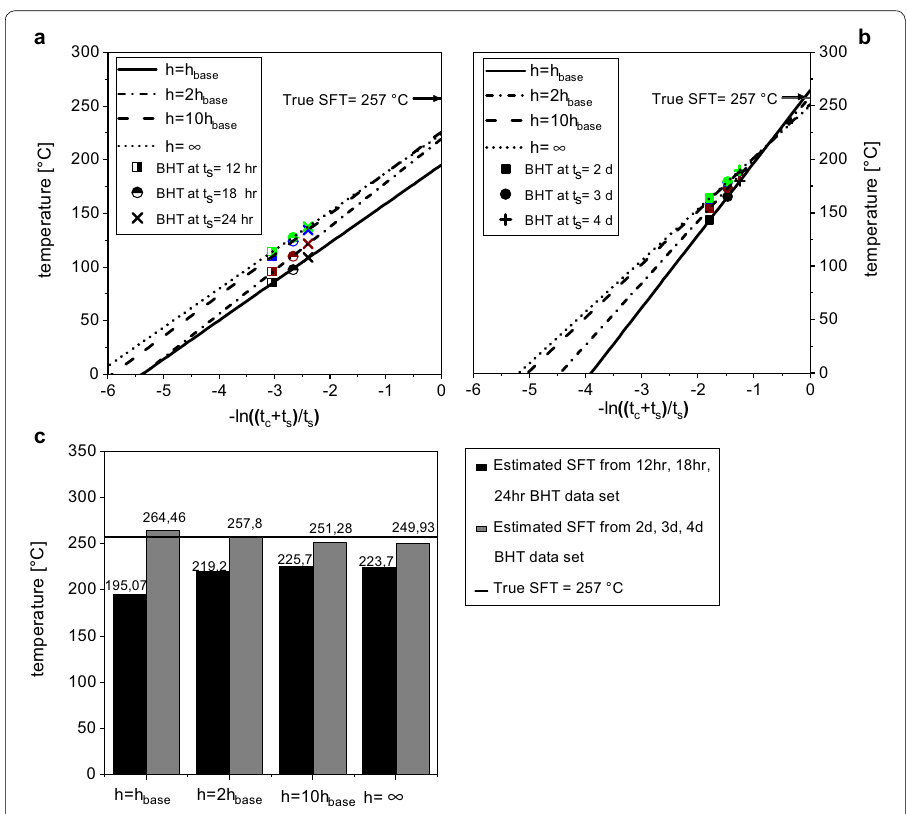
Fig. 4 The HM plots (lines) using BHT measurements (markers) at a early shut-in time ( t s and b long-term shut-in ( t s 2, 3, and 4 days) for each of the four different heat transfer coefficients ( h ) = considered. c Comparison of the results of SFT estimation with the true SFT value: the black bars are the four SFT estimates using early shut-in time BHT data; the dark grey bars represent the four SFT estimates using long-term shut-in BHT data; the solid line stands for the referencing value which is the true SFT (257